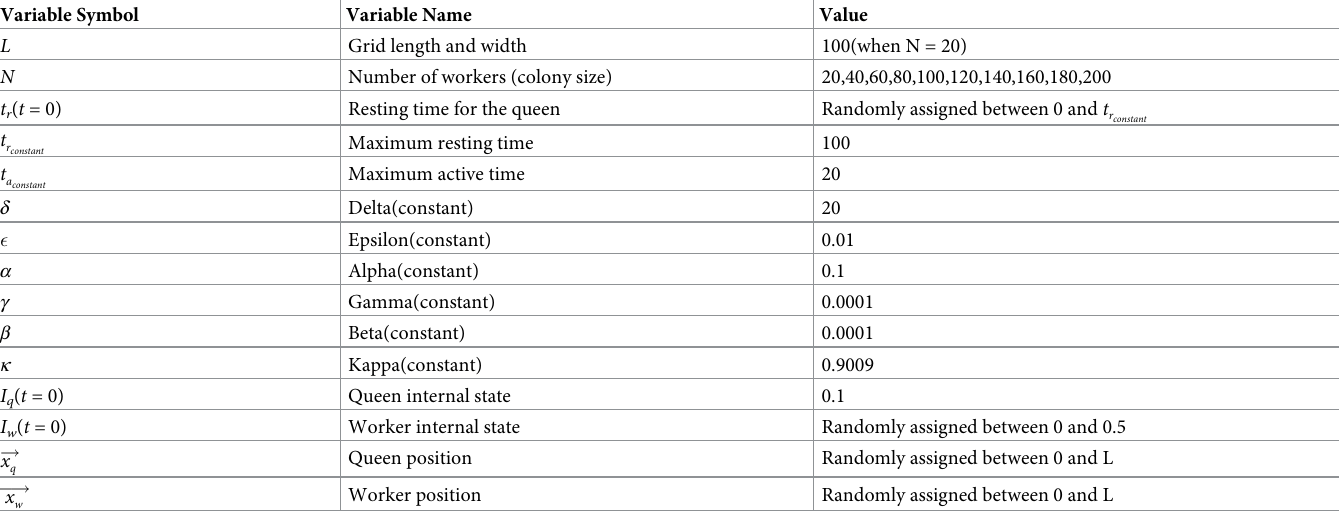
Table 1. Variables, constants, and initial conditions used in the agent-based simulation.